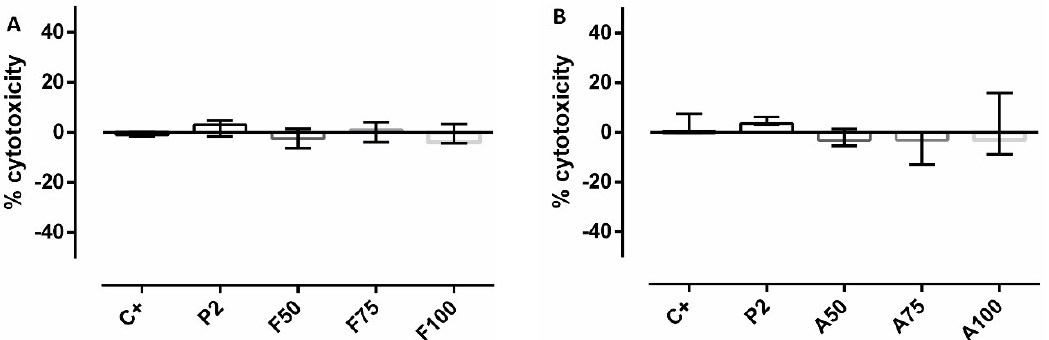
Figure 7. Percentage of MC3T3-E1 cytotoxicity without treatment (positive control, C + ) or treated with P2 or with the fluconazole-loaded ( A ) or anidulafungin-loaded ( B ) sol–gel coatings. Bars represent mean and standard deviation of the percentage of cytotoxicity estimated in three biological